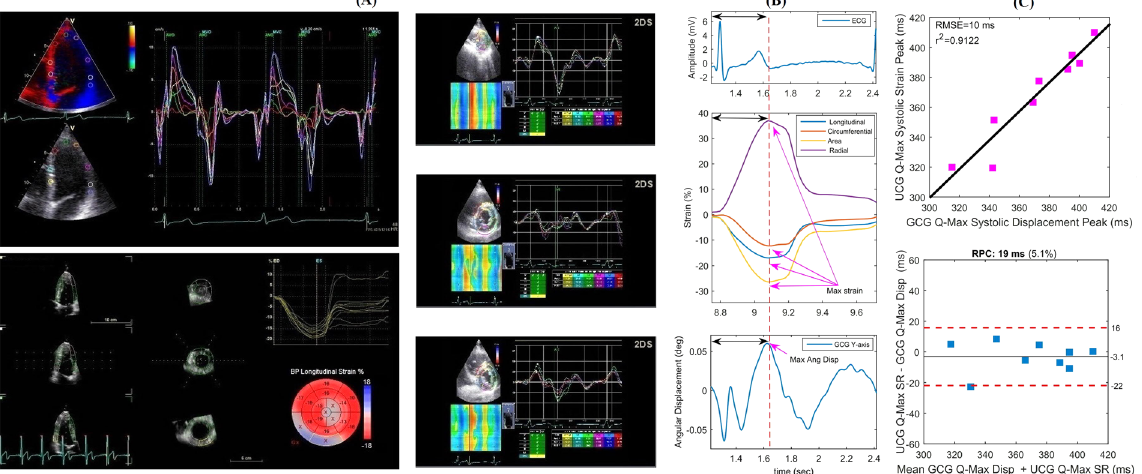
longitudinal, circumferential and radial directions ( A ). Electromechanical delays measured by TDI and GCG ( B ). Relationship between the GCG and TDI electromechanical delays ( C ).